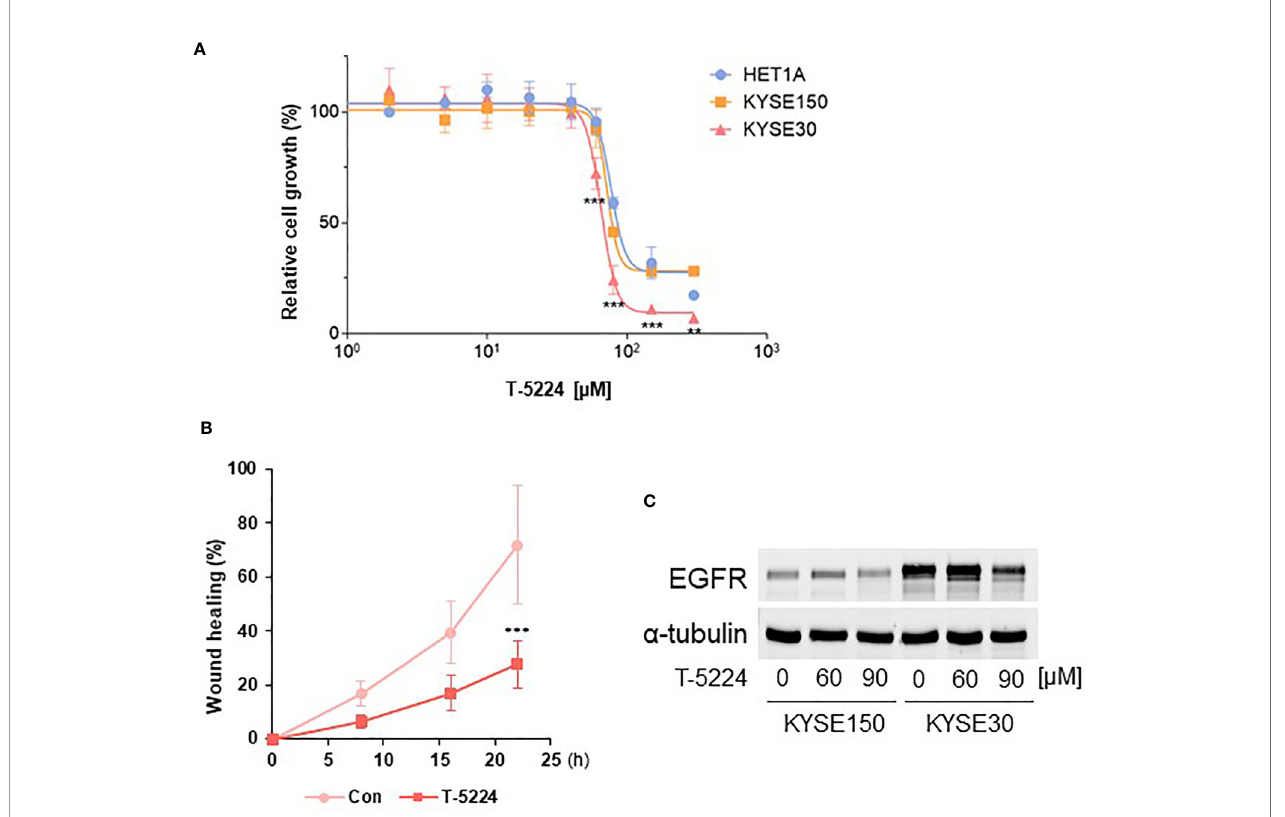
FIGURE 6 | Inhibition of proliferation and migration of KYSE-30 cells by AP-1 inhibitor T-5224. (A) Cell viability rates upon different doses of T-5224 for 24 h were measured with MTT assay. Data are shown as nonlinear fi t of log-dose vs . response curves. Error bars represents mean ± SD from three independent experiments. *** p -value < 0.001, ** p -value < 0.01 compared to HET-1A at each time point. (B) Wound healing rate of KYSE-30 cells upon 60 m M T-5224 treatment was plotted in the indicated post-wound time points. *** p -value < 0.001 compared to control (DMSO-treated) in each time point. (C) Representative Western blot shows that EGFR expression decreased by T-5224 in KYSE-30 cells. Indicated concentrations of T-5224 were treated for 24 h in both cell